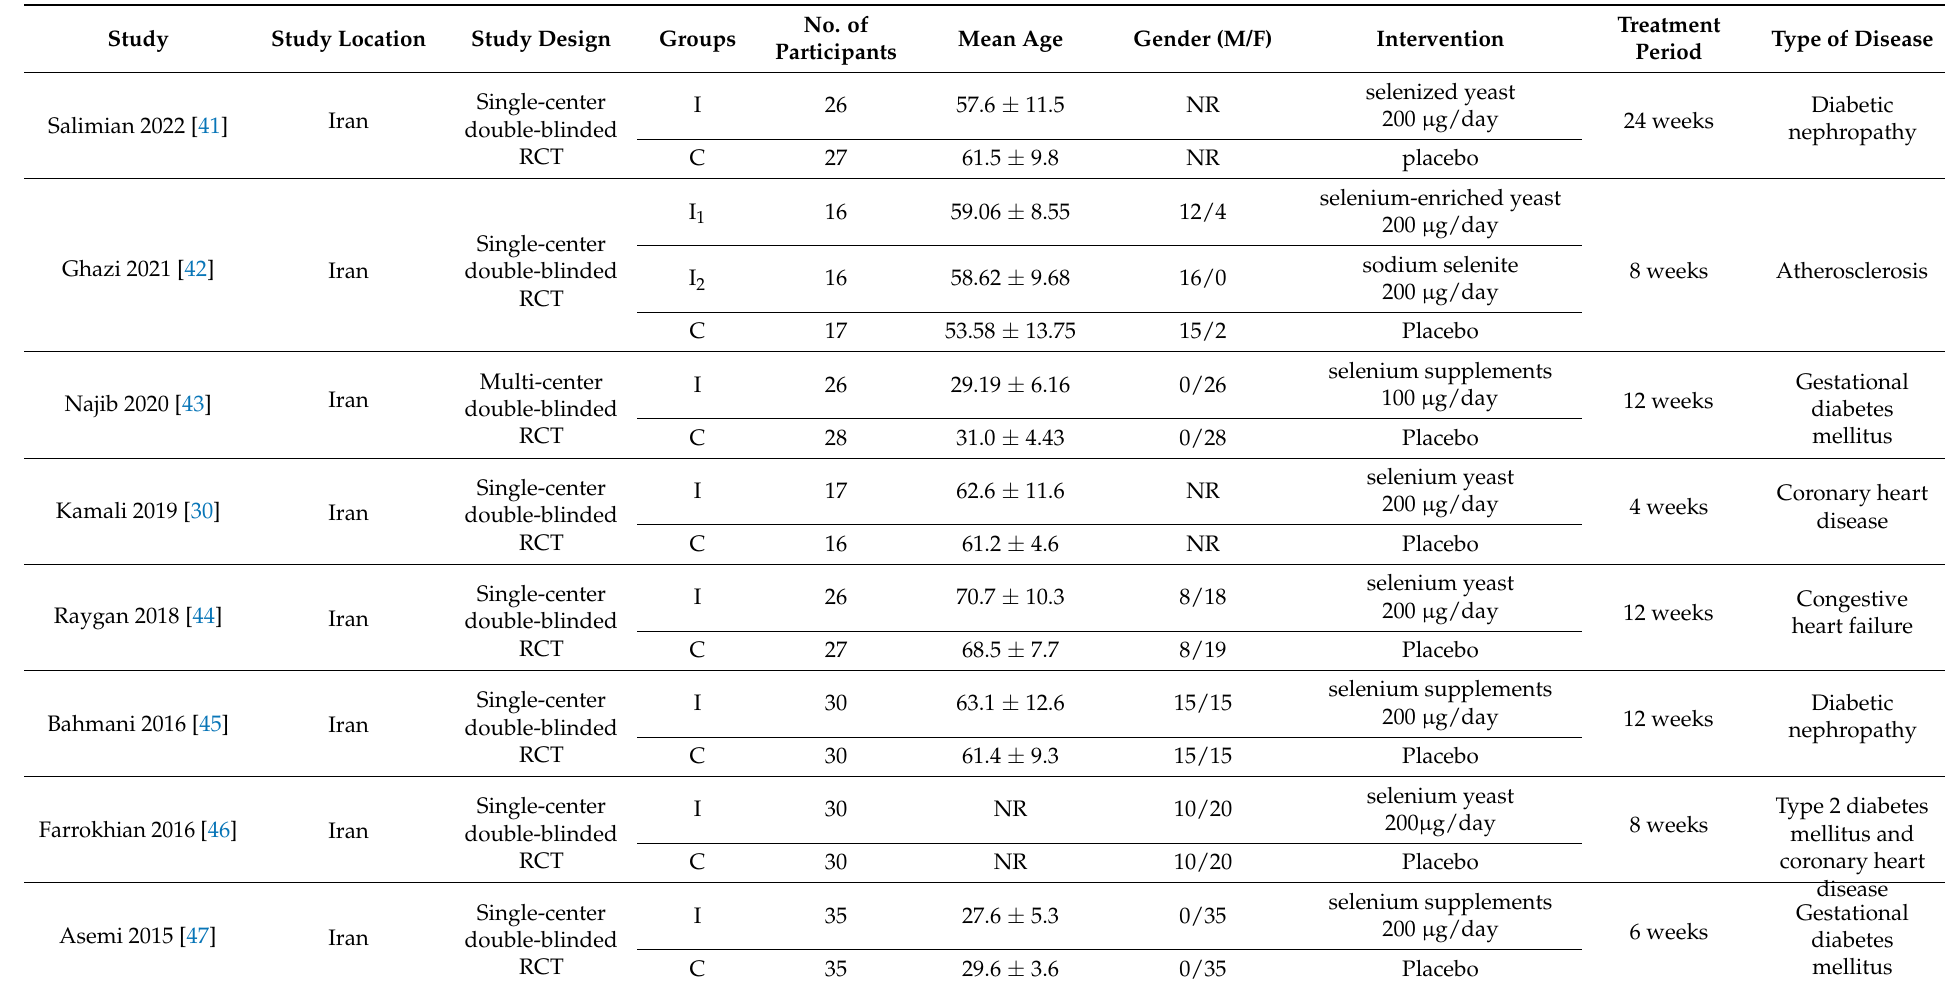
Table 1. Characteristics of the included